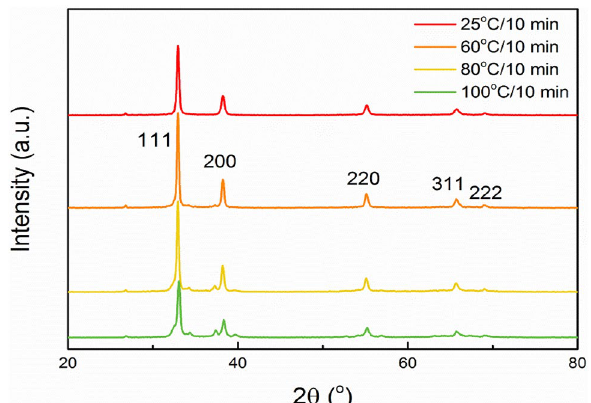
Figure 1. XRD patterns of Ag 2 O NPs synthesized under the reaction time of 10 min, and the temperatures are 25 °C, 60 °C, 80 °C, 100 °C, respectively.